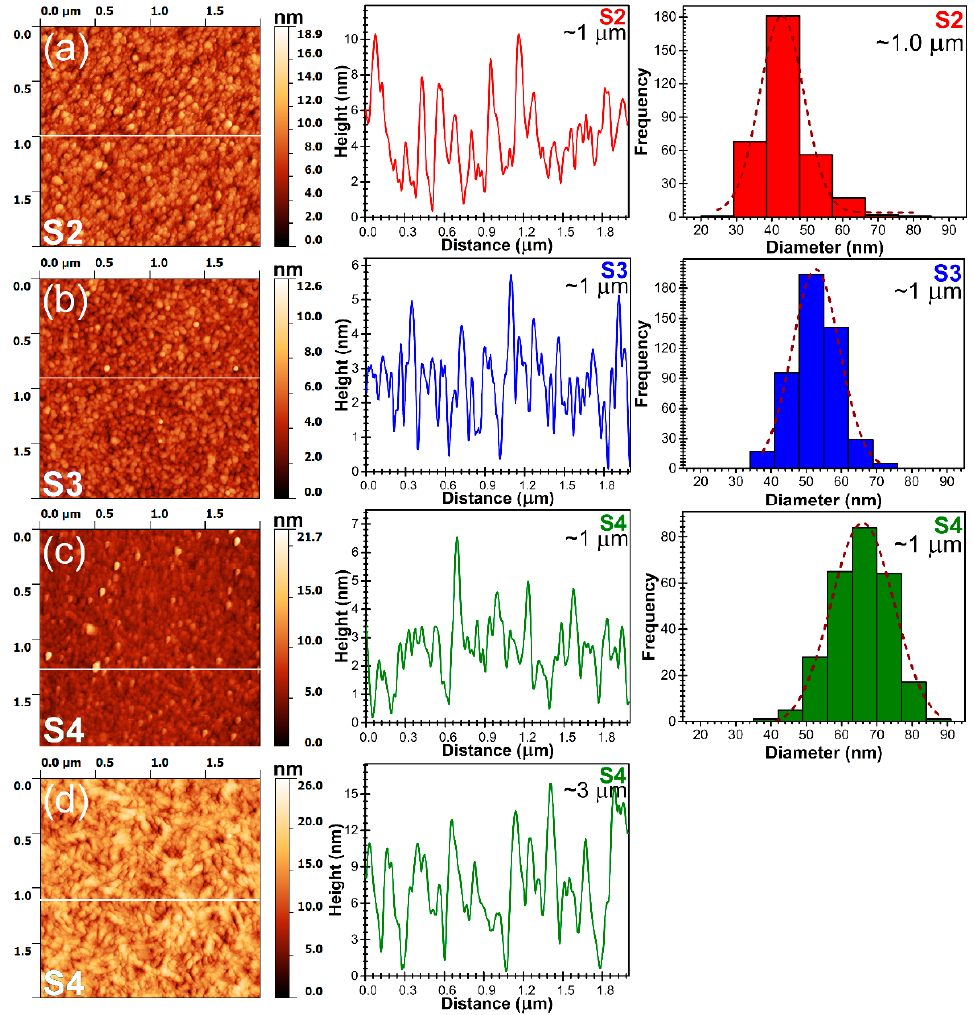
Figure 1. Characteristic atomic force microscopy (AFM) images, height profiles for the corresponding lines drawn in AFM images and grain size distribution histograms for AlN films deposited by reactive RF-MS starting from different base pressure levels: ( a ) S2 ≈ 1.0 μ m, ( b ) S3 ≈ 1.0 μ m, ( c ) S4 ≈ 1.0 μ m and ( d ) S4 ≈ 3.0 μ m. Table 2. Root mean square roughness (R RMS ) values inferred from the AFM measurements performed on 2 μ m × 2 μ m microscopic fields for AlN films deposited under different working conditions.